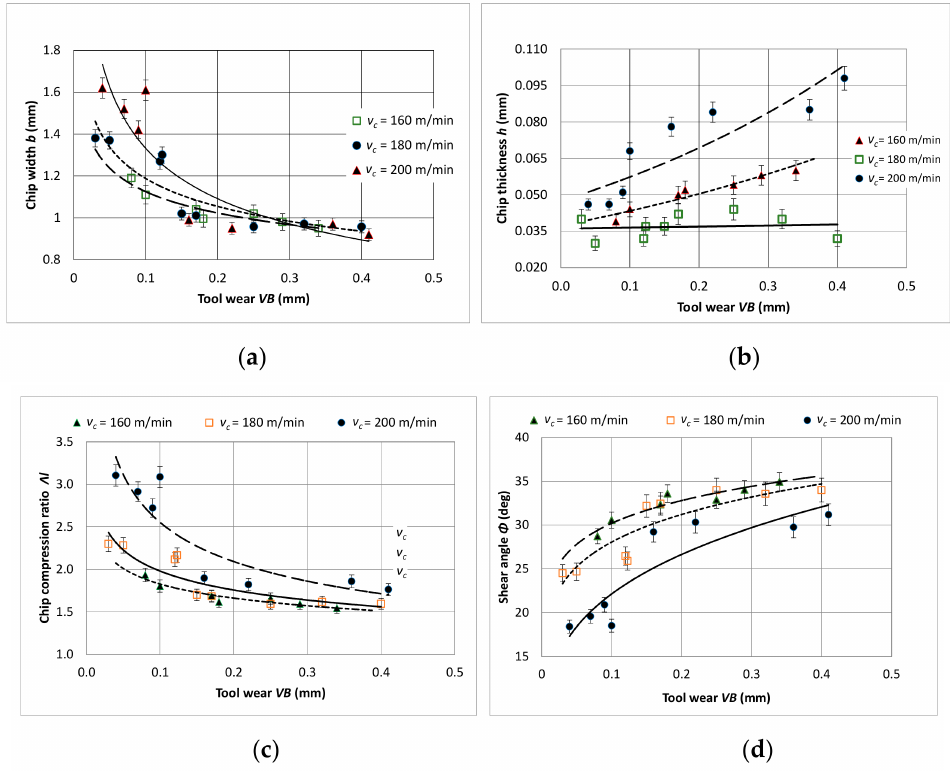
Figure 23. Geometric dimensions of the chips in relation to the wear of the cutting edge ( a ) chip width, ( b ) chip thickness, ( c ) chip compression ratio, ( d ) shear angle; a p = 0.5